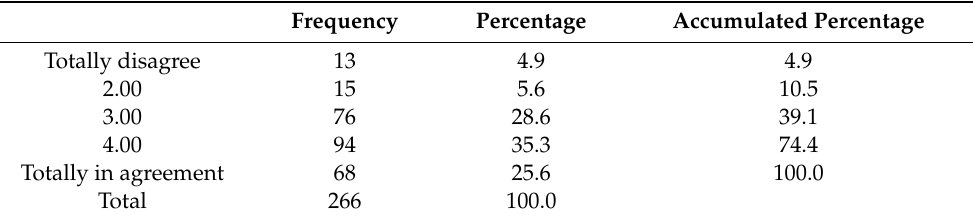
Table 6. Willingness to pay more for environmentally friendly or green hotels.